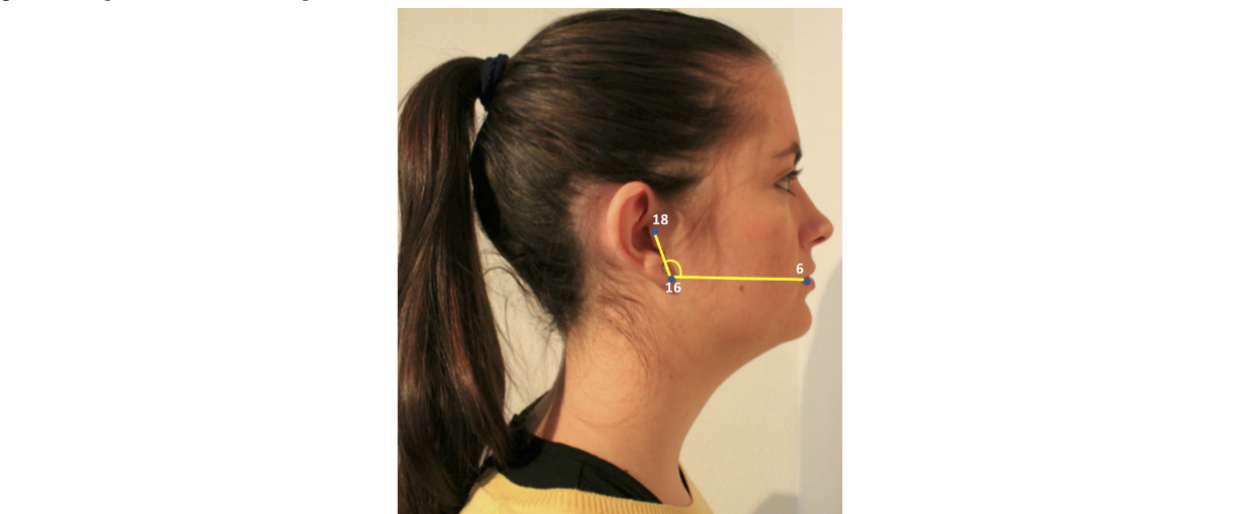
Figure 5. Tragion-ramus-stomion